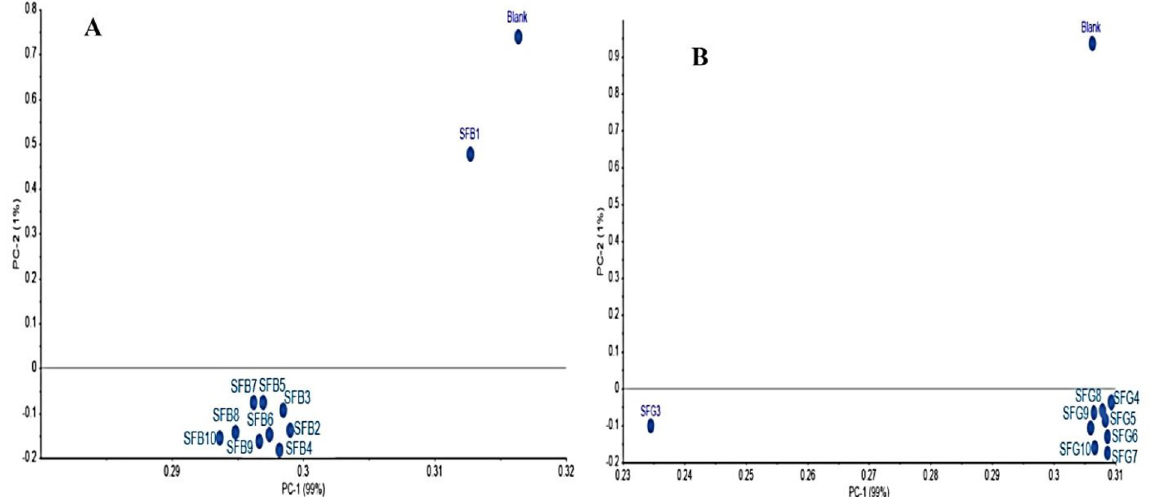
Fig 7. PCA done for FTIR spectra of activated carbon prepared from black (SFB) and green (SFG) olive stone after treatment of sunflower oil.